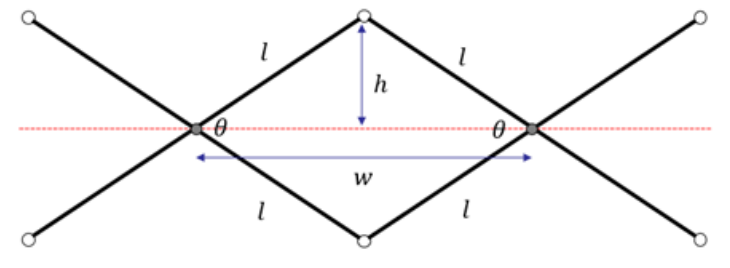
Figure 7. An elementary scissor-hinge unit is